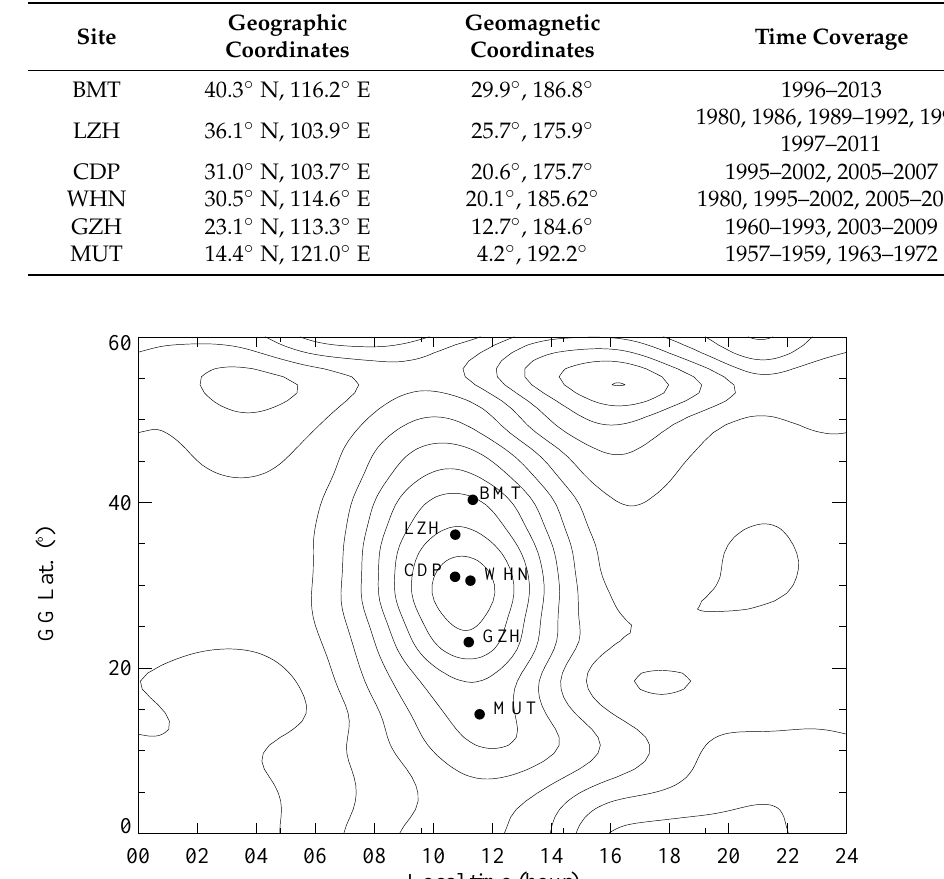
Figure 1. Schematic diagram of the geomagnetic observatories’ locations used in this study, along the 120° E meridian chain, relative to the Northern Hemisphere solar quiet (Sq) current focus. “GG Lat.” represents the geographic latitude. Table 1. Coordinates and time coverage of the geomagnetic observatories used in this study. Site Geographic Coordinates